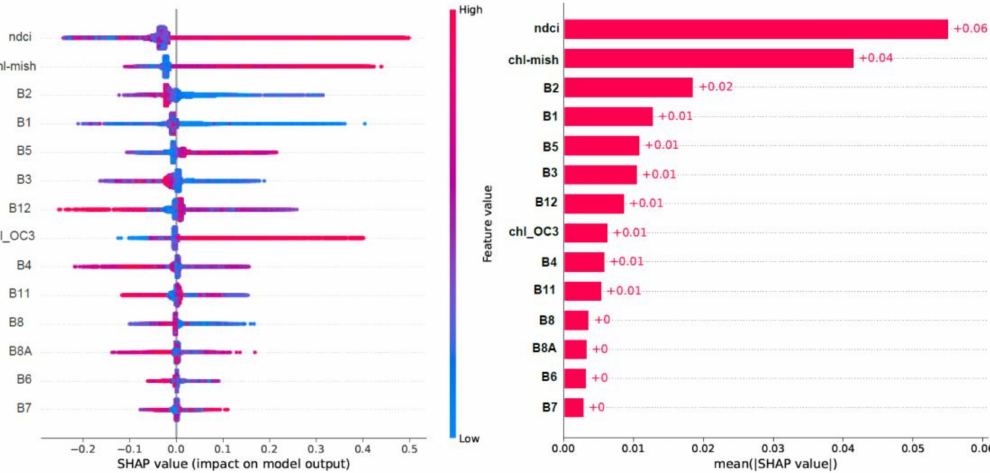
Figure 6. Summary SHapley Additive exPlanations (SHAP) values ( left ) and mean of absolute SHAP values ( right